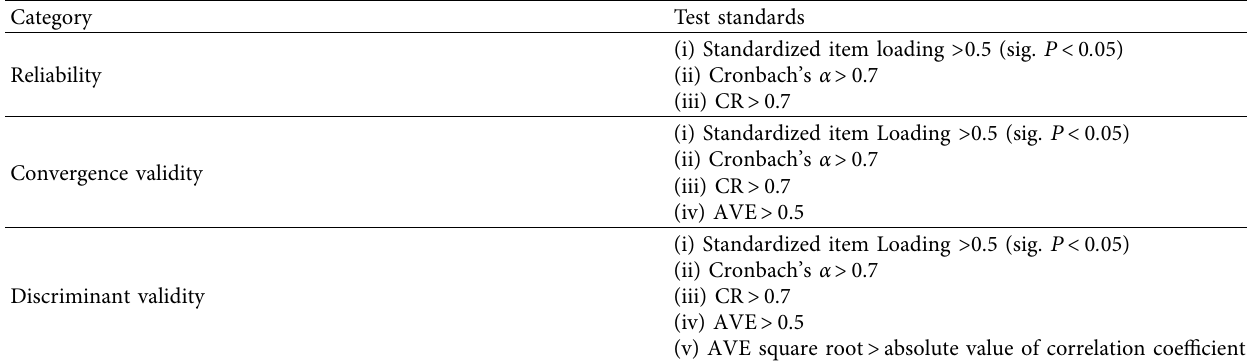
Table 4: Test standards for reliability and validity of the measurement